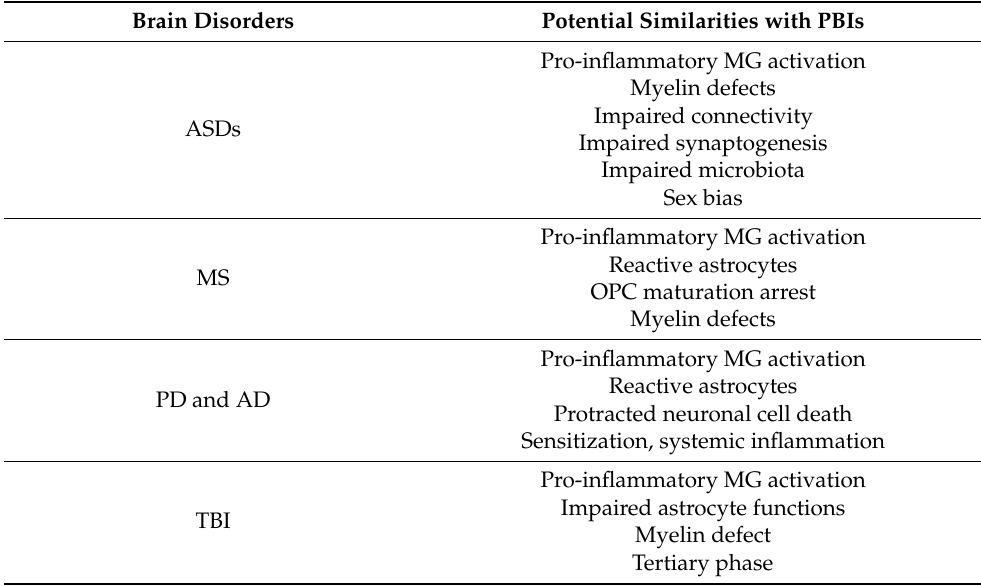
Table 3. Potential overlap between PBIs and other brain